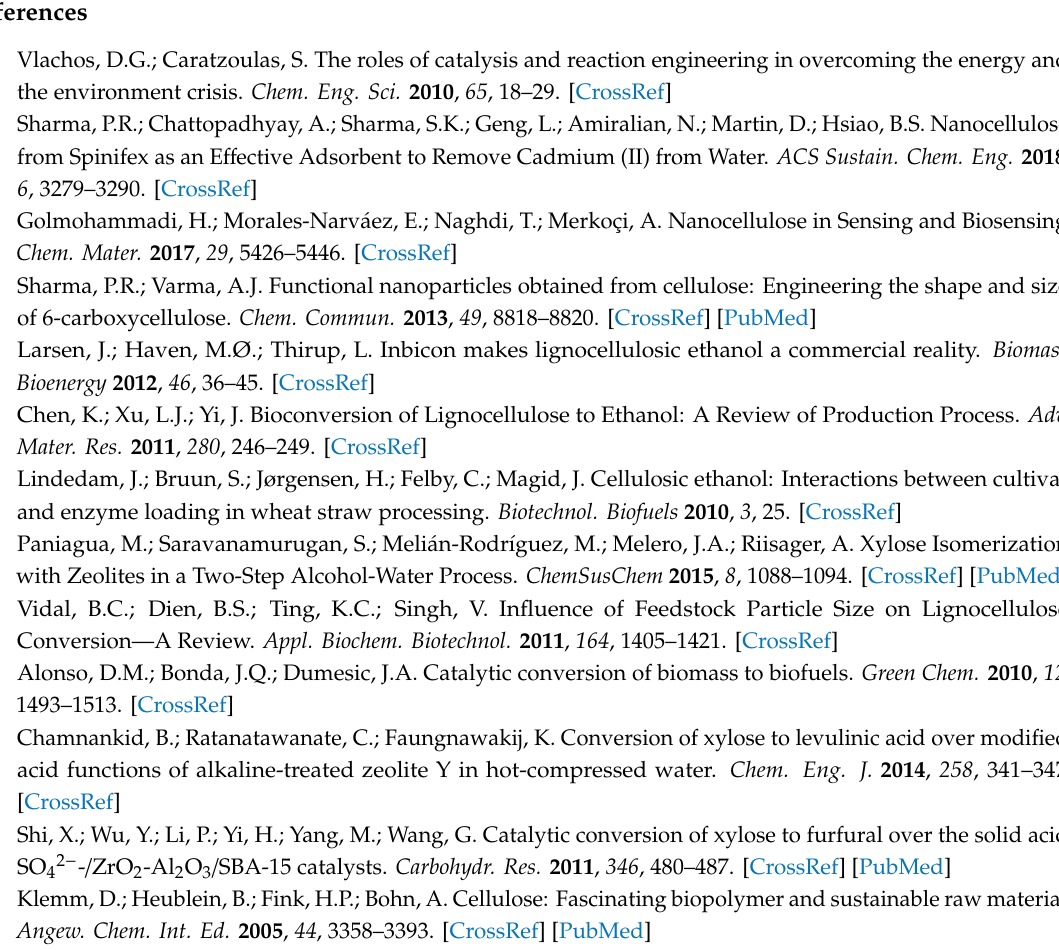
Figure S1: High-resolution TEM images of (A) fresh 1 wt.% Ru / Al 2 O 3 (1) catalyst, (B) used 1 wt.% Ru / Al 2 O 3 (1) catalyst, (C) fresh 3 wt.% Ru / Al 2 O 3 (1) catalyst, (D) used 3 wt.% Ru / Al 2 O 3 (1) catalyst, (E) fresh 5 wt.% Ru / Al 2 O 3 (1) catalyst and (F) used 5 wt.% Ru / Al 2 O 3 (1) catalyst, Figure S2: Overlay of 1 H- 13 C HSQC and 1 H- 13 C HMBC NMR spectra of post-reaction material displayed as contour plots, showing the single and multiple-bond correlations in 2-methoxy-1,4-benzoquinone, with the inset displaying the full chemical shift assignment of the compound. Figure S3: High-resolution TEM catalysts images of (left) fresh 5 wt.% Ru / Al 2 O 3 (3) catalyst, and (right) 5 wt.% Ru / Al 2 O 3 (3) catalyst after five reaction